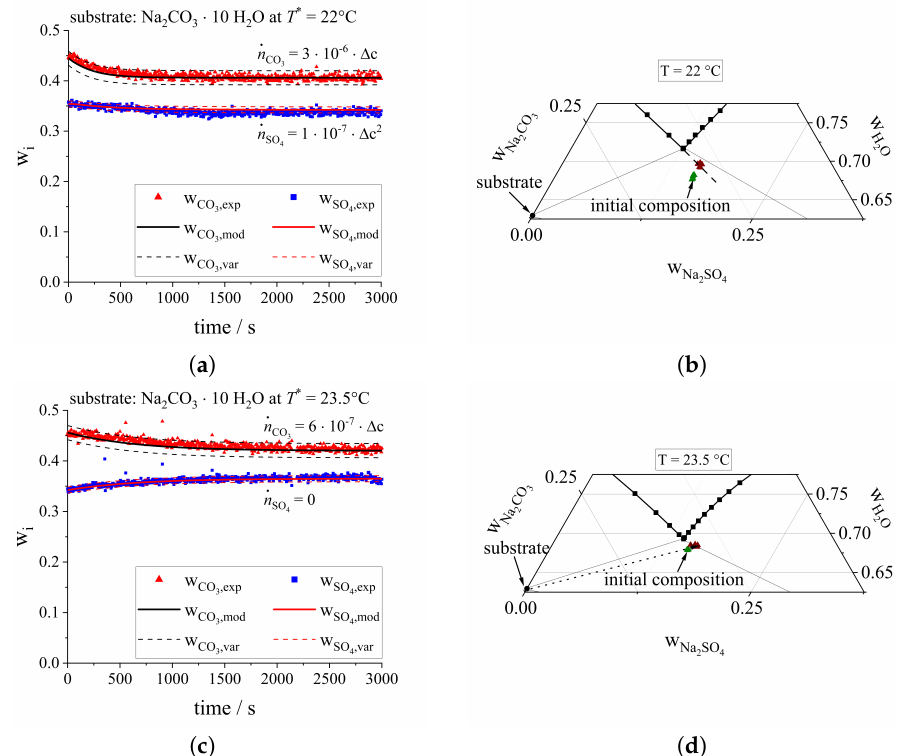
Figure 10. In Diagram ( a ), a desupersaturation course of a simultaneous crystallizing ternary material system is shown. In ( c ), the course of a phase separation process is presented. The given equations represent the average kinetics of all conducted experiments. Dashed lines represent the accuracy range, which was taken as the measurement uncertainty of a Raman measurement for both compo- nents. Further diagrams and calibration data are provided in the supporting information (compare Figures S19–S21). Diagrams ( b , d ) represent the starting (green triangles) and end points (brown triangles) of both processes.